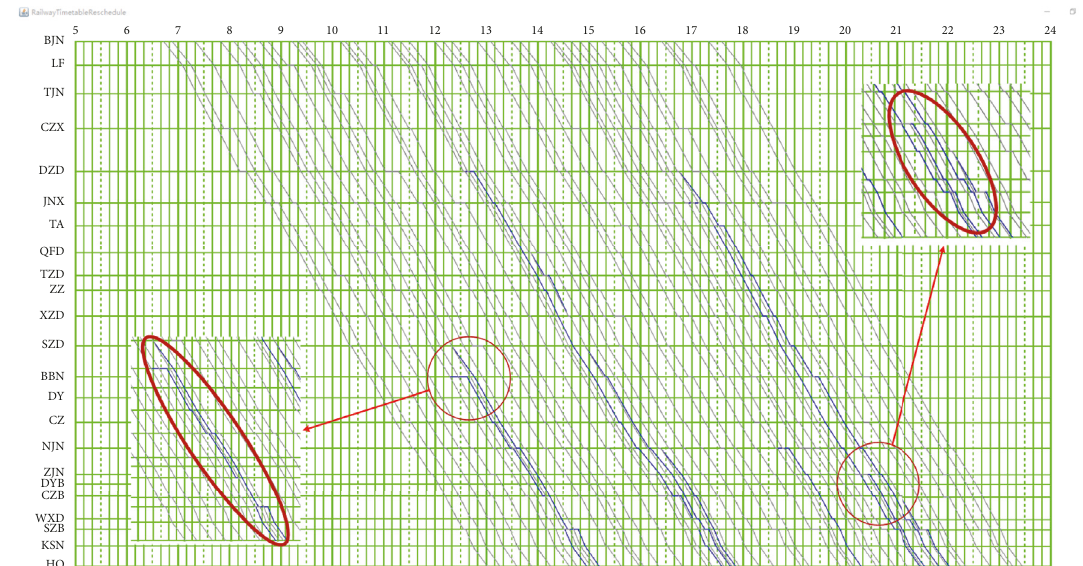
Figure 7: The best rescheduled time-distance diagram based on the proposed